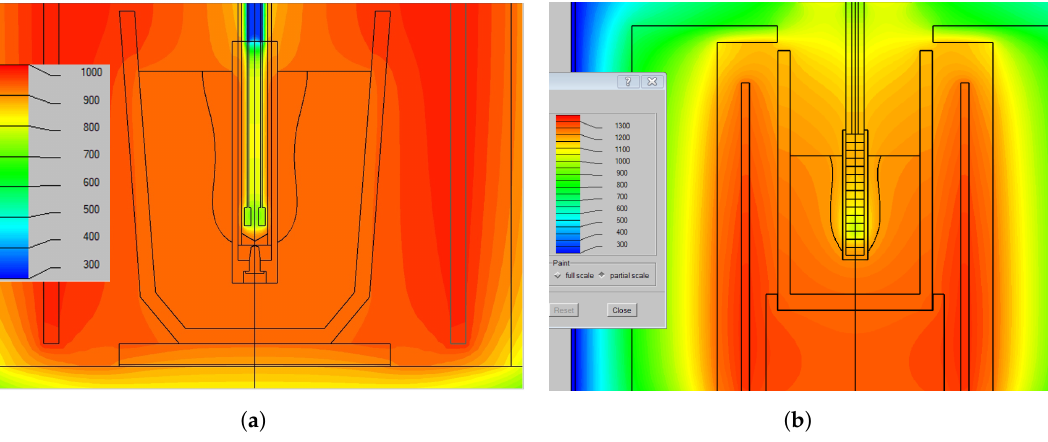
Figure 8. Simulation results obtained by the software CrysVUn for ( a ) aluminum and ( b ) for